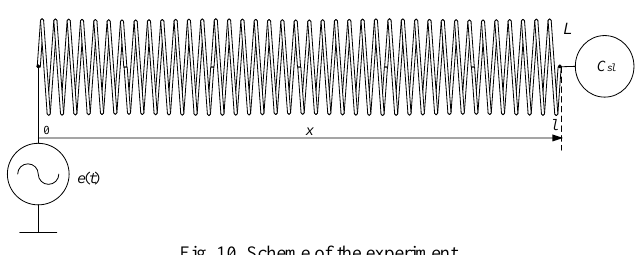
Fig. 10. Scheme of the